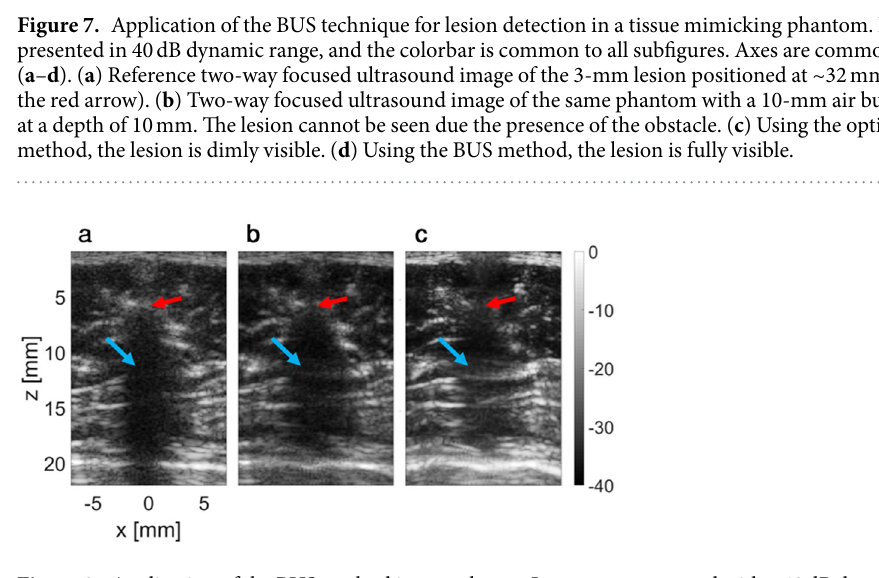
Figure 8. Application of the BUS method in a rat thorax. Images are presented with a 40 dB dynamic range, and the colorbar is common to all subfigures. Axes are common to subfigures ( a – c ). ( a ) Standard two-way focused ultrasound image of the area behind the rat spine. The red arrow indicates the position of a vertebra that obscures the tissue behind it (blue arrow). ( b ) Results of the optimized PI method. ( c ) Results of the BUS method, showing a notable improvement in the imaging of the tissue behind the